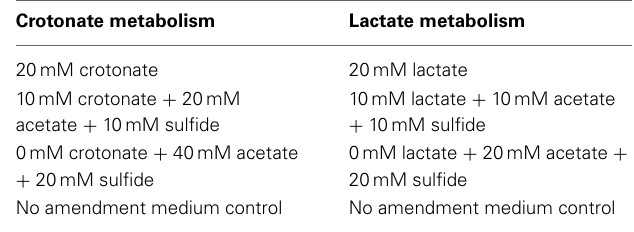
Table 3 | Uninoculated medium controls containing various concentrations of fatty acids and sulfide amended to represent crotonate metabolism by S. aciditrophicus strain SB or lactate metabolism by Desulfovibrio sp. strain